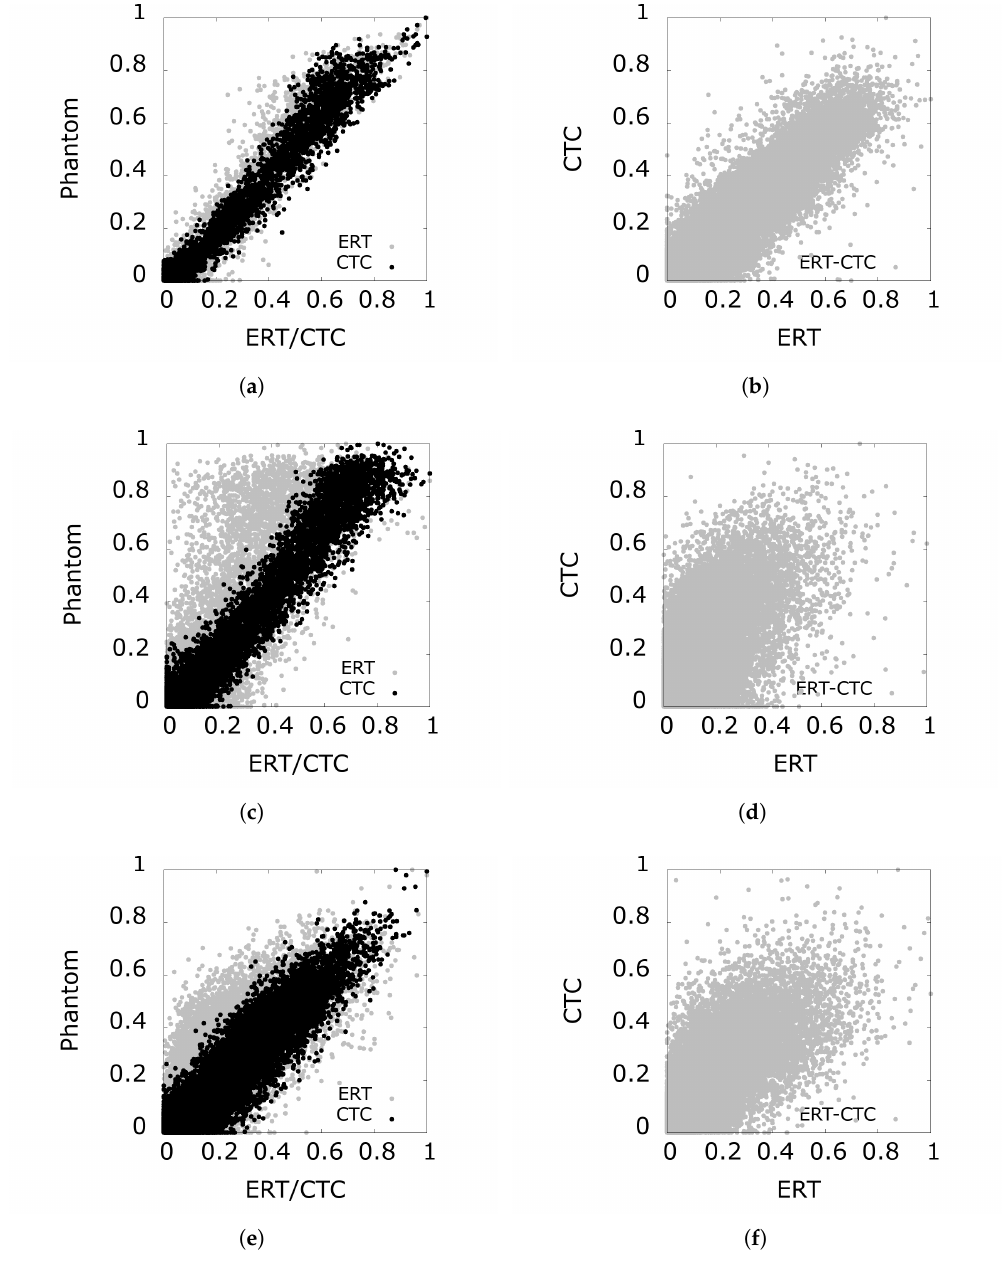
Figure 17. Scatter plots of the phantom ( left ) column and experimental ( right ) column reconstructions. ( a ) Bunsen flame phantom; ( b ) Bunsen flame; ( c ) Swirl flame phantom; ( d ) Swirl flame; ( e ) Cambridge–Sandia stratified flame phantom; ( f ) Cambridge–Sandia stratified